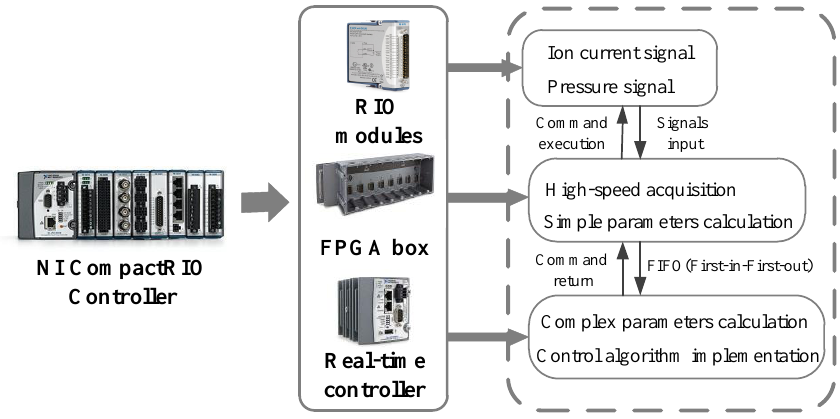
Figure 6. Structure of ion current/cylinder pressure cooperative combustion diagnosis and control system.